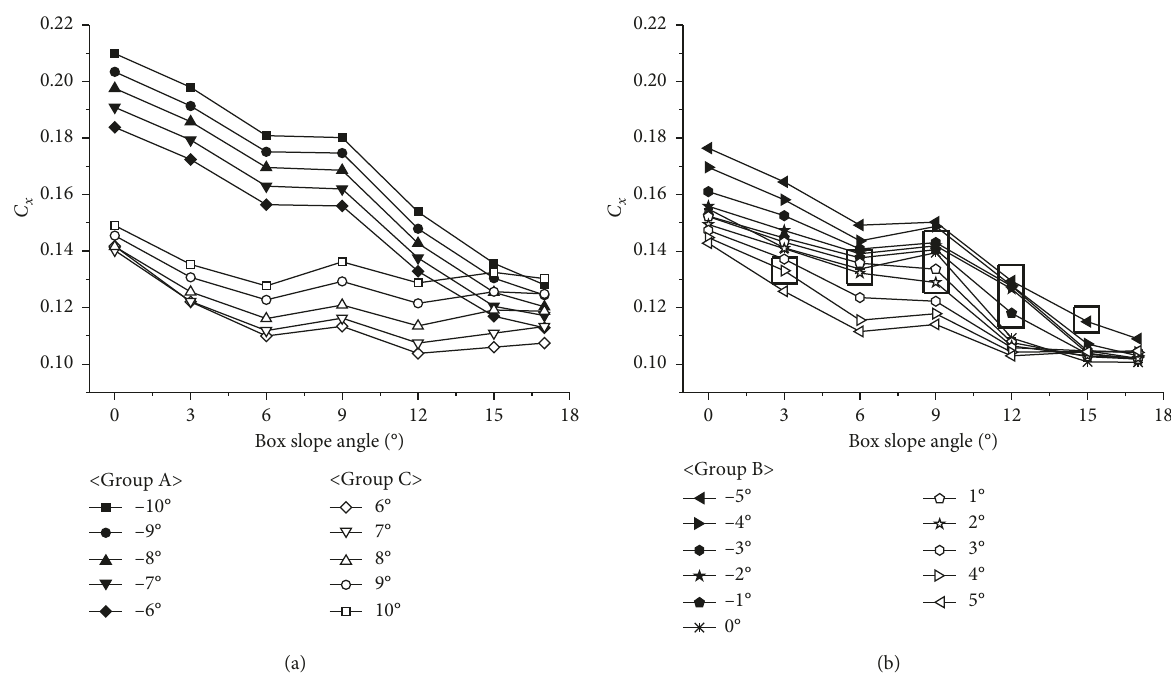
Figure 12: C x vs. box slope angle for various AOA: (a) groups A and C; (b) group B.